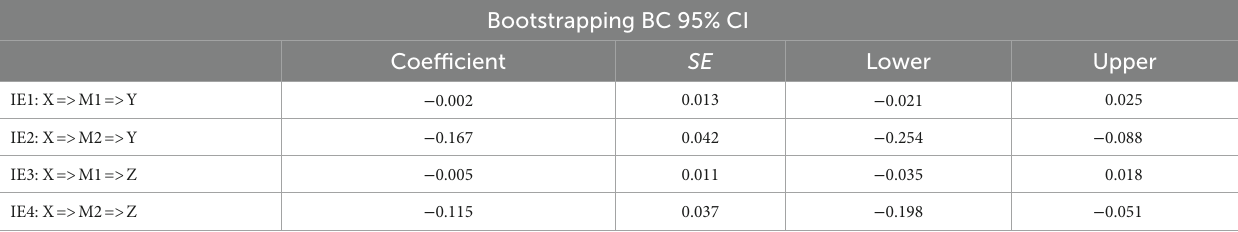
TABLE 6 Indirect effects of the serial multiple mediator model of the effect of burnout (x) on selfefficacy (Y) and performance (Z) through prevention- focused job crafting (M1) and promotion-focused job crafting (M2).